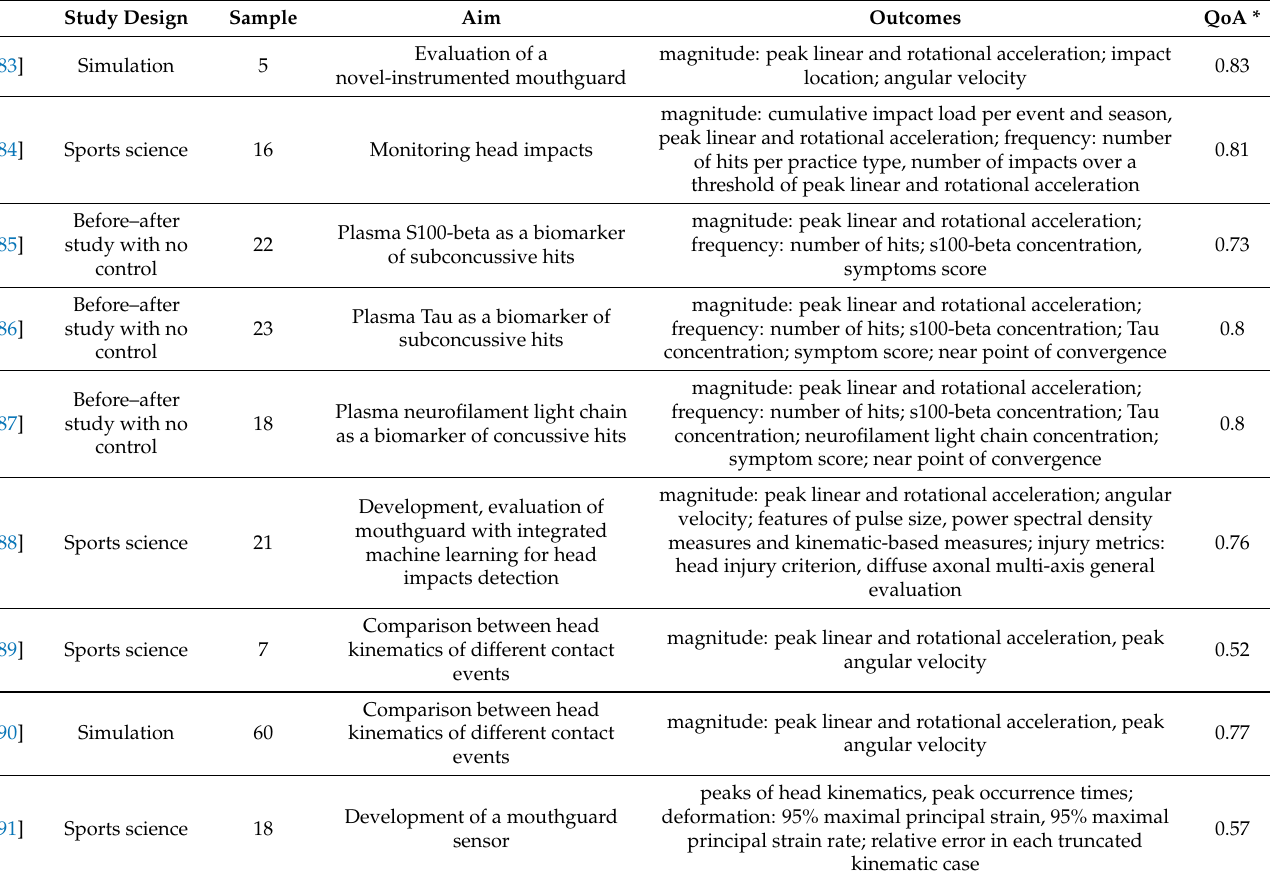
Table 3. Studies regarding the biomechanics of concussions studied by